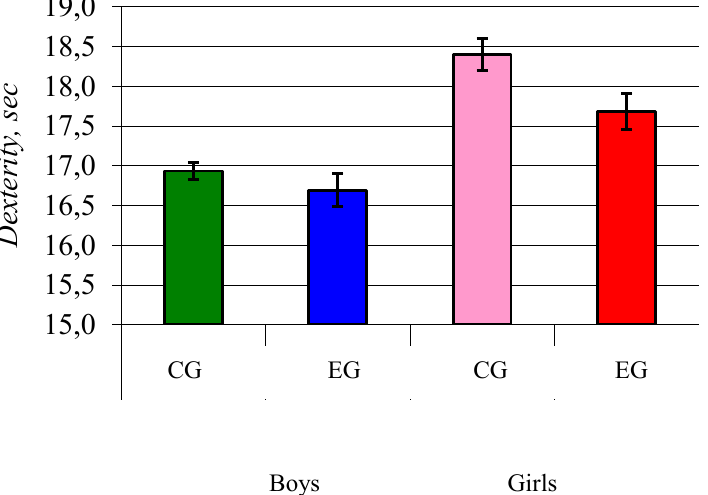
Girls Boys Girls Fig.3 Flexibility and static balance of countryside teenagers of 7 th form in control (CG) and experimental (RG) groups after forming research